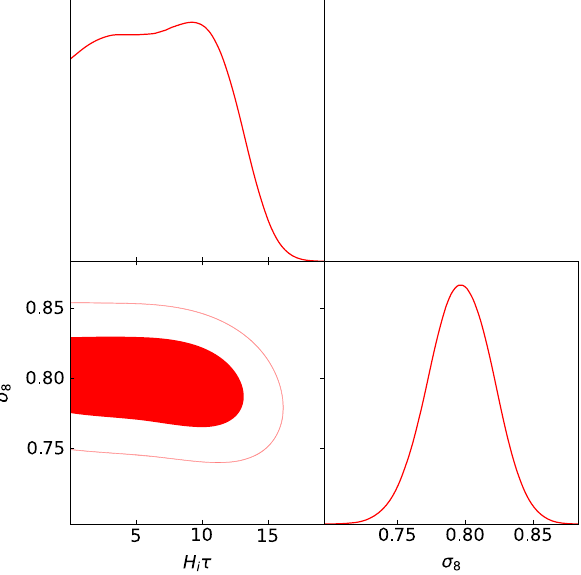
Fig. 16 Marginalized posterior distributions of the time delay param- eter τ and σ 8 using the combined growth rate and f σ 8 ( z ) datasets. The median estimates are H i τ = 7 . 12 + 4 . 60 − σ = 0 . 80 ± 0 . 8